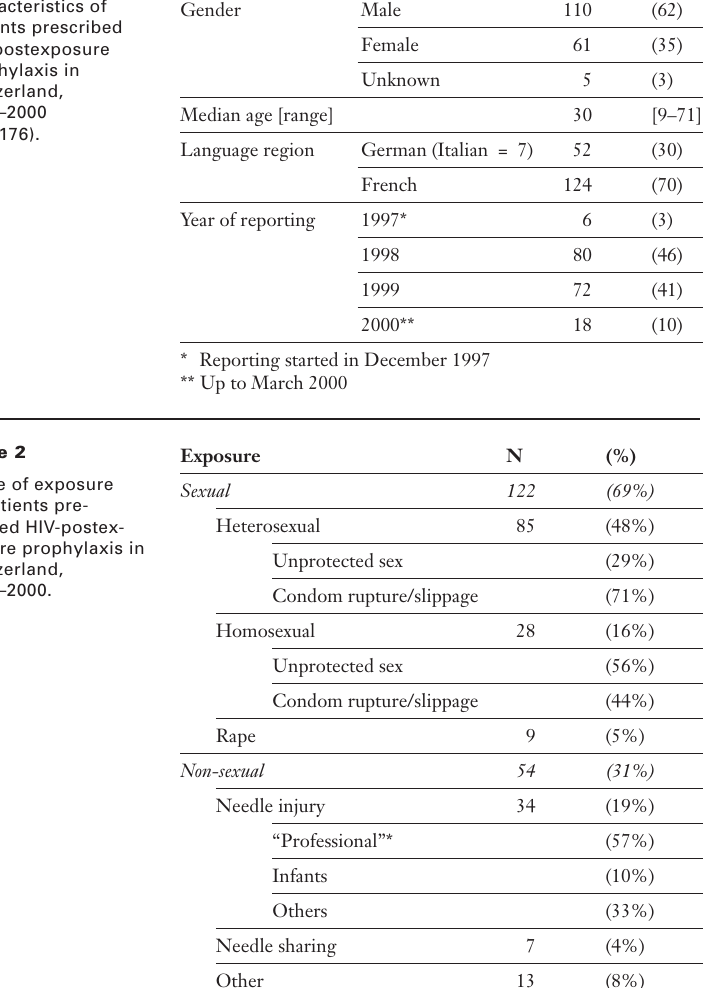
Characteristics of patients prescribed HIV-postexposure prophylaxis in Switzerland, 1997–2000